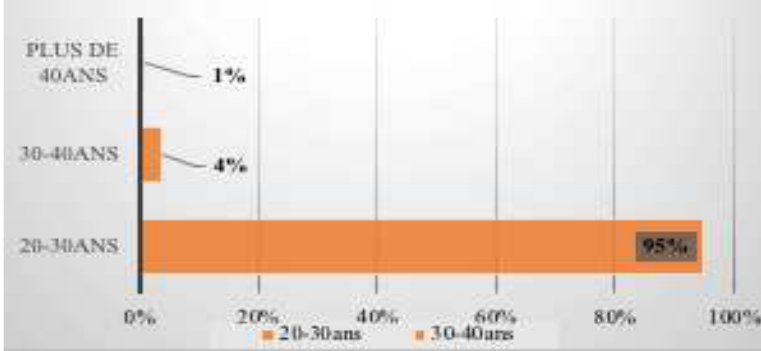
Fig. 2. Proportions globales de l’échantillon selon l’âge.